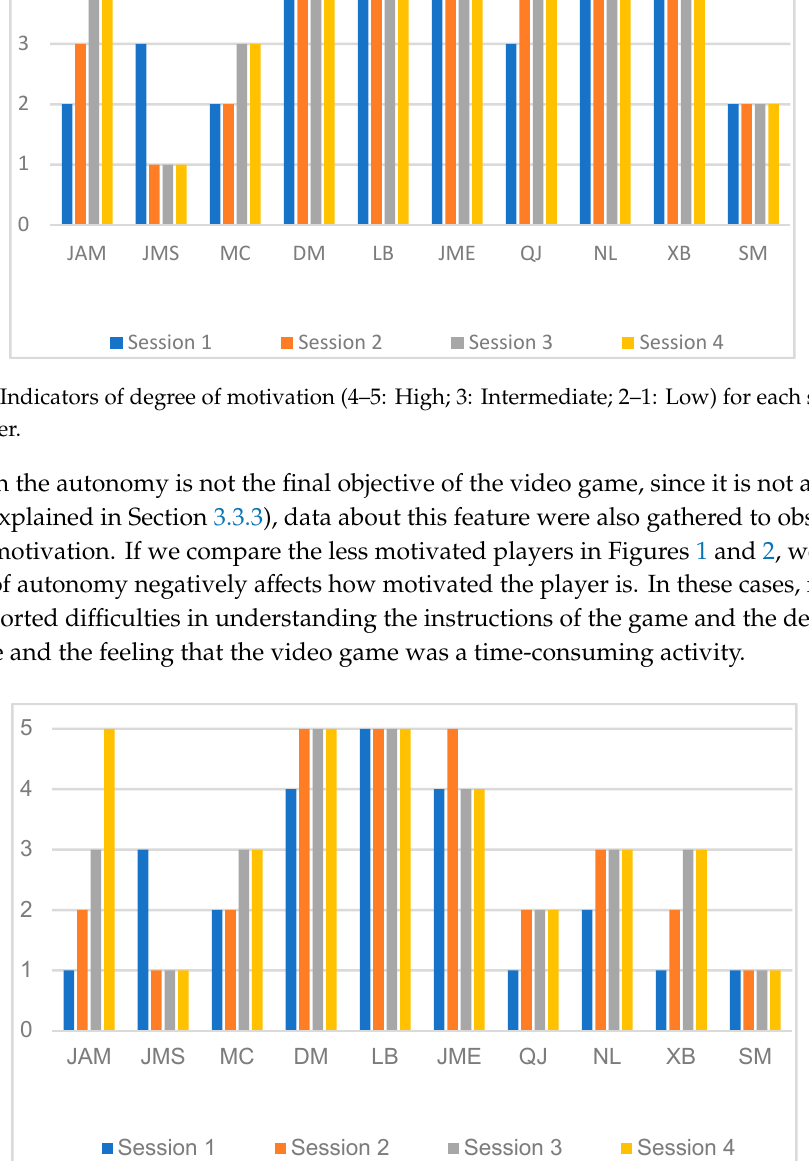
Figure 2. Indicators of degree of autonomy (4–5: High; 3: Intermediate; 2–1: Low ) for each session of each player.